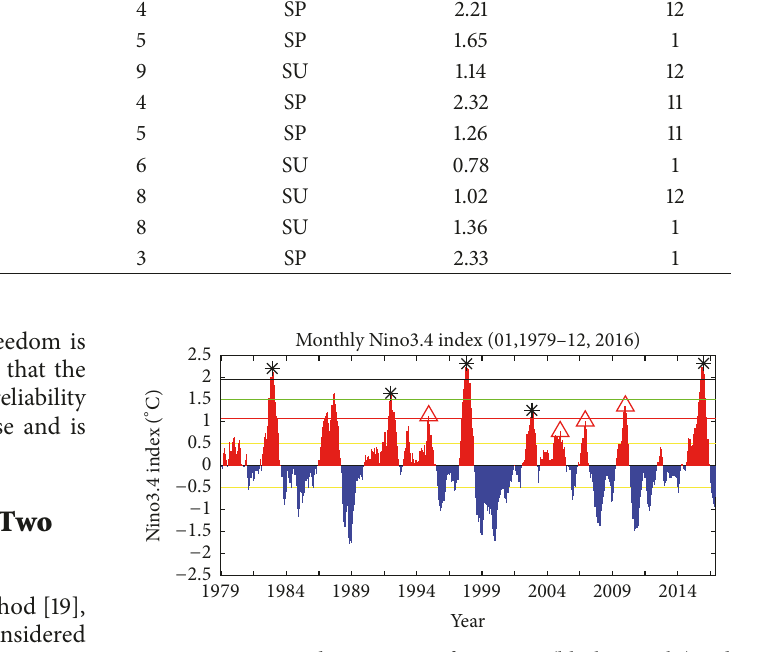
Figure 1: Ni˜no3.4 index time series for SP-type (black asterisks) and SU-type (red triangles) El Ni˜no events. The horizontal black (red) line indicates the mean value of the SP (SU) type. The horizontal green line indicates the mean value of all (SP and SU) events combined. The horizontal yellow lines indicate the ± 0.5 index